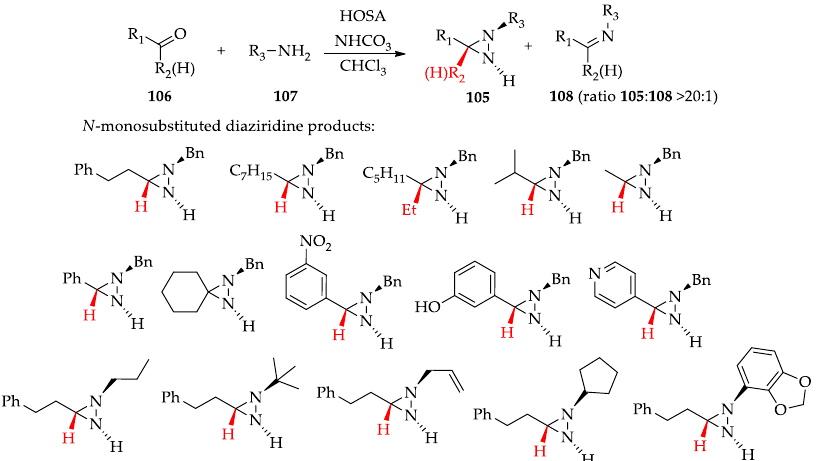
Figure 14. N -monosubstituted diaziridines 105 synthesis from simple aldehydes or ketones 106 with amines 107 .